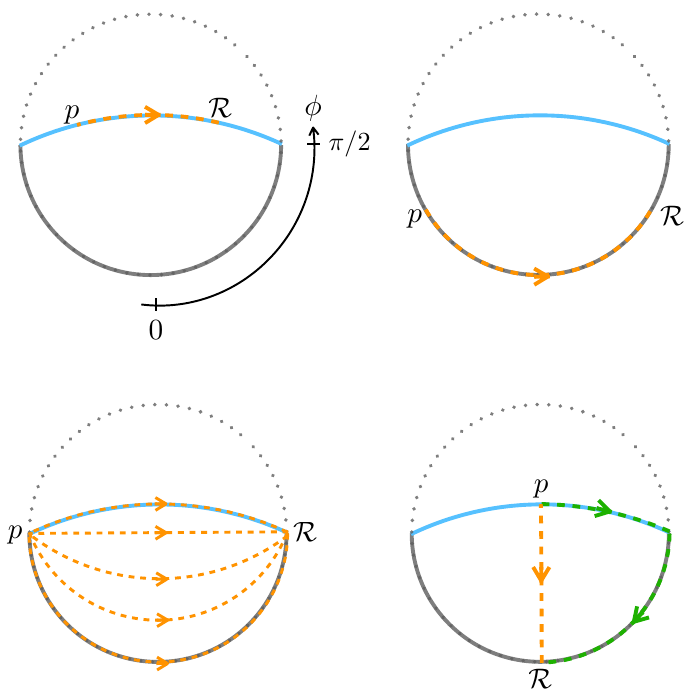
Figure 5 . Projection of the null geodesics connecting p and the observer R on to a time slice for different situations. The orange dotted curves are the fastest paths in the bulk M . The green dotted curves are the fastest paths on the boundary ∂ M = Σ ∪ Q . The shortest path on the boundary ∂ M is omitted if it coincides that in the bulk M